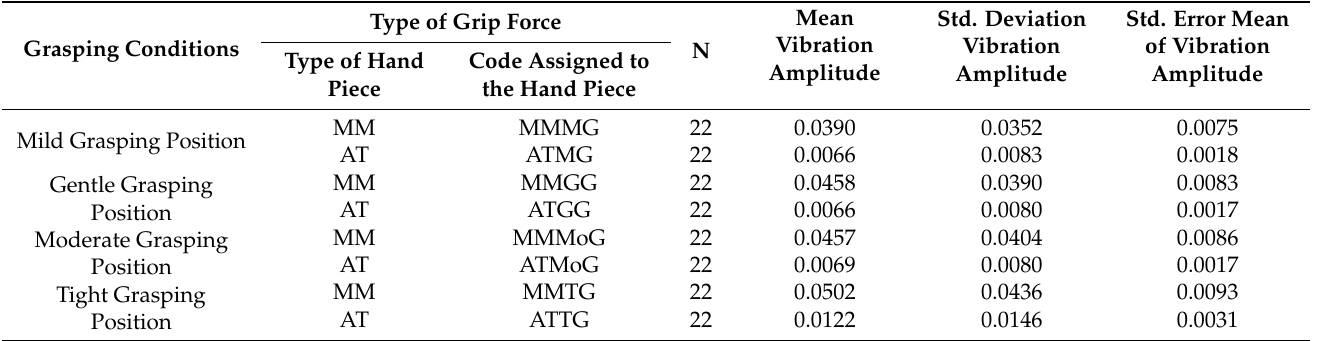
Table 5. Descriptive statistics for 1/3-Octave band vibration amplitude with different grasping